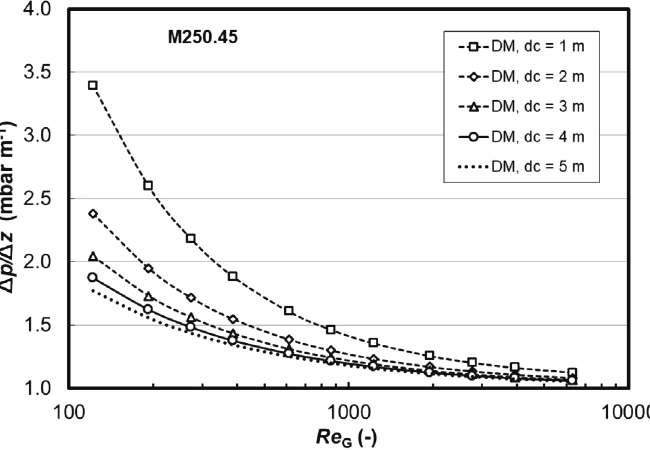
Fig. 5 – Effect of column diameter on specific pressure drop of original DM for most conventional type and size of corrugat- ed sheet structured packing, over the whole range of Reynolds numbers for the hypothetical operating conditions base